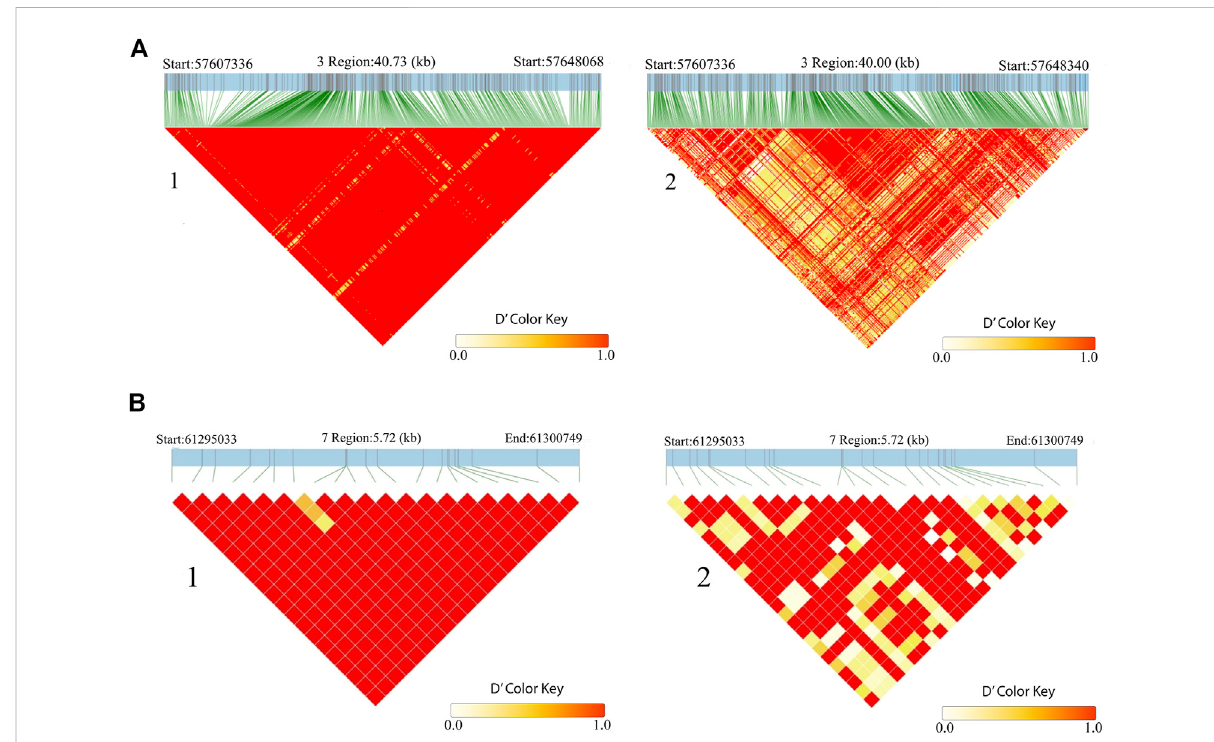
FIGURE 8 LD block heatmap of the candidate genes of CLCA2 (A) and SLC26A2 (B) in the high-altitude (1) and low-altitude (2) cattle populations.